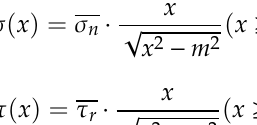
Figure 11. Stress analysis of rock mass with locked section.